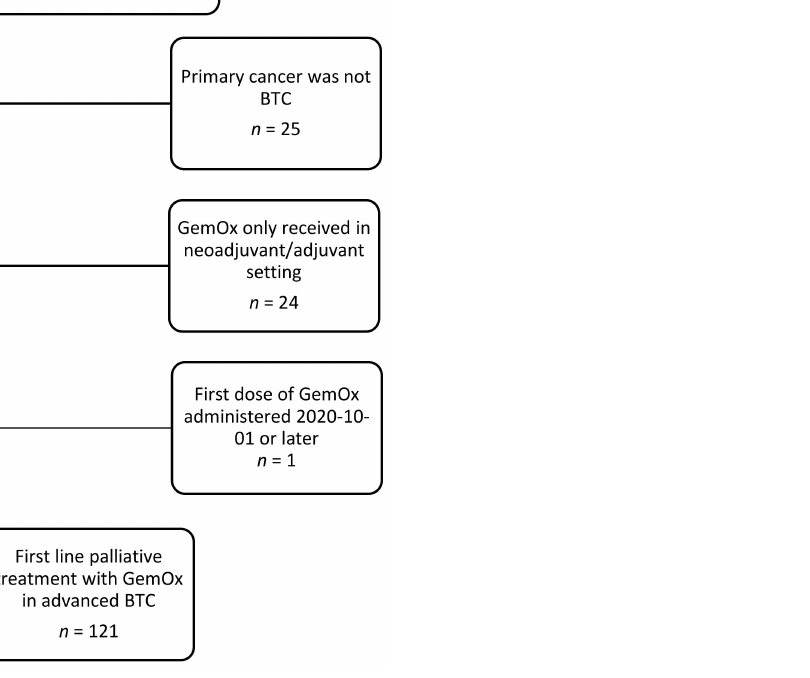
Figure 1. Flow chart of study population. BTC: biliary tract cancer; GemOx: gemcitabine plus oxaliplatin; n : number of